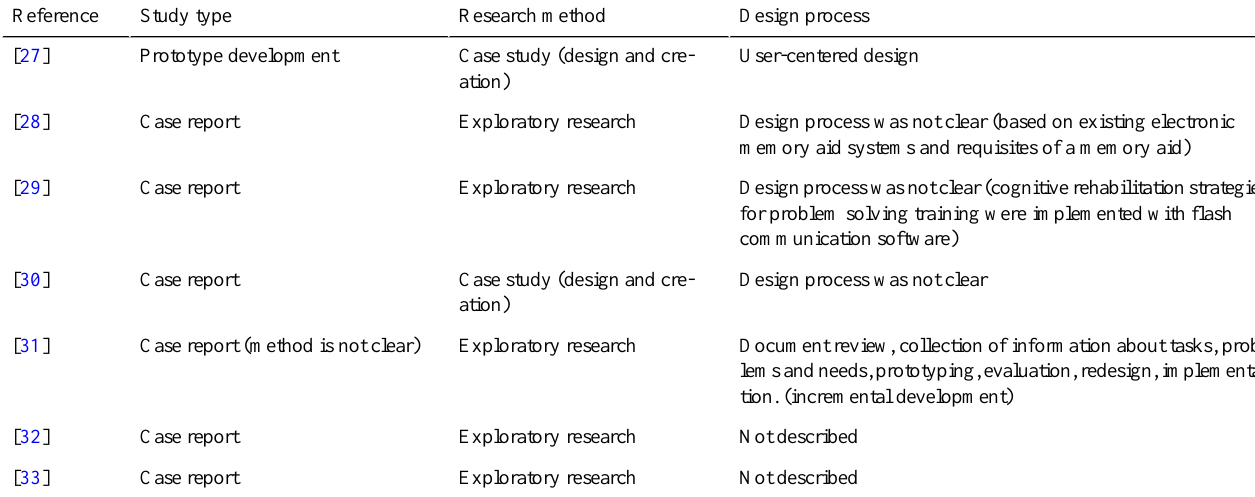
Table 3. Study type and research method.